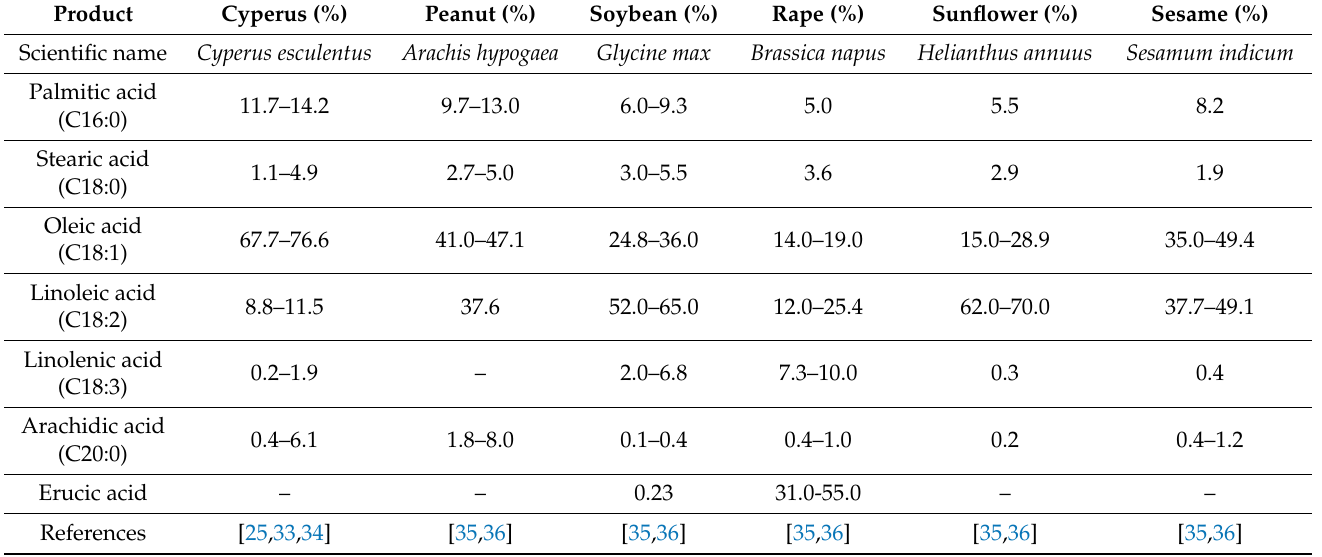
Table 3. Main fatty acid composition and content of cultivated Cyperus ( Cyperus esculentus L.) oils compared to those of common vegetable oils (Crude